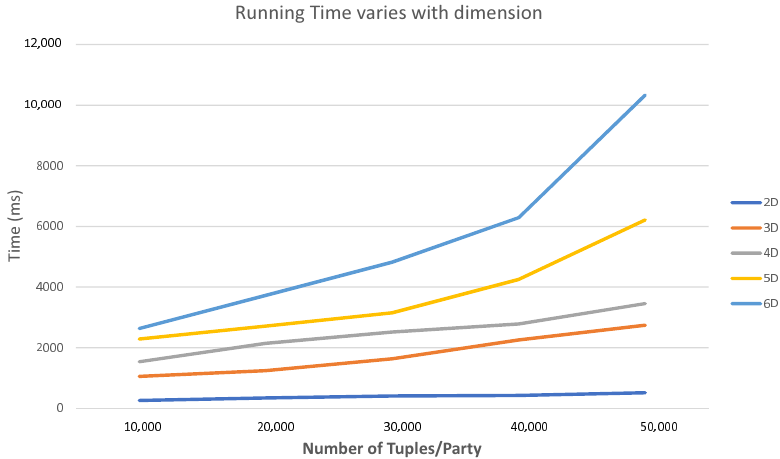
Figure 8. Running time varies with objects attributes (distribution: independent, partitions: